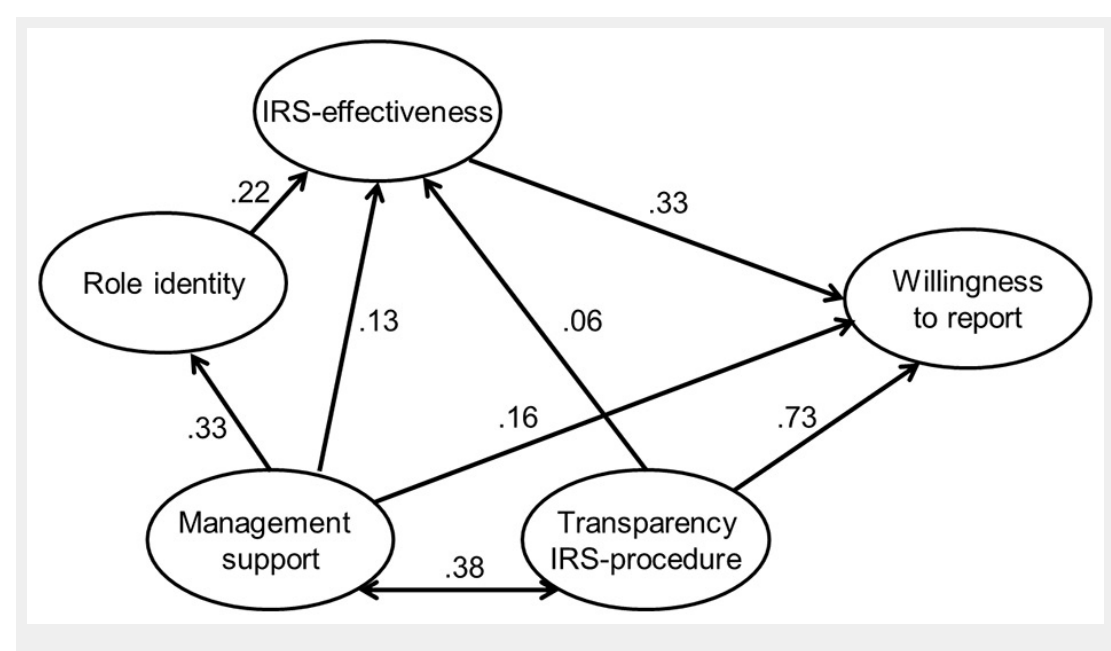
Figure 1 Integrated model of motivational antecedents, the figures indicating the unstandardised path